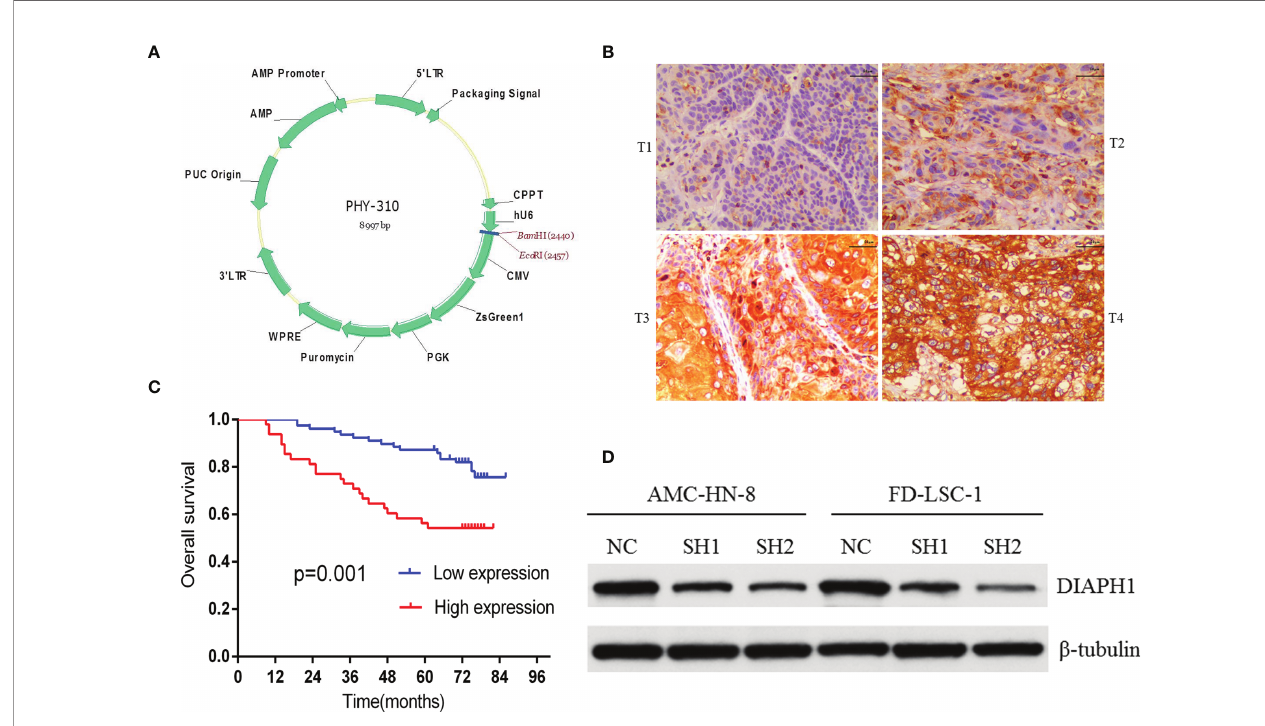
FIGURE 1 | The relationship between DIAPH1 expression and clinical samples and DIAPH1 knockdown ef fi ciency in cells. (A) The lentivirus vector atlas used in DIAPH1 knockdown by shRNA lentivirus. (B) Immunohistochemistry analysis of DIAPH1 expression of laryngeal squamous cell carcinoma at different tumor stages (T1-T4, scale bar 50 m m). (C) Kaplan – Meier curves for overall survival strati fi ed according to DIAPH1 protein expression level. (D) Western blot analysis of DIAPH1 protein expression in DIAPH1 knockdown (SH) cells and the negative control (NC)